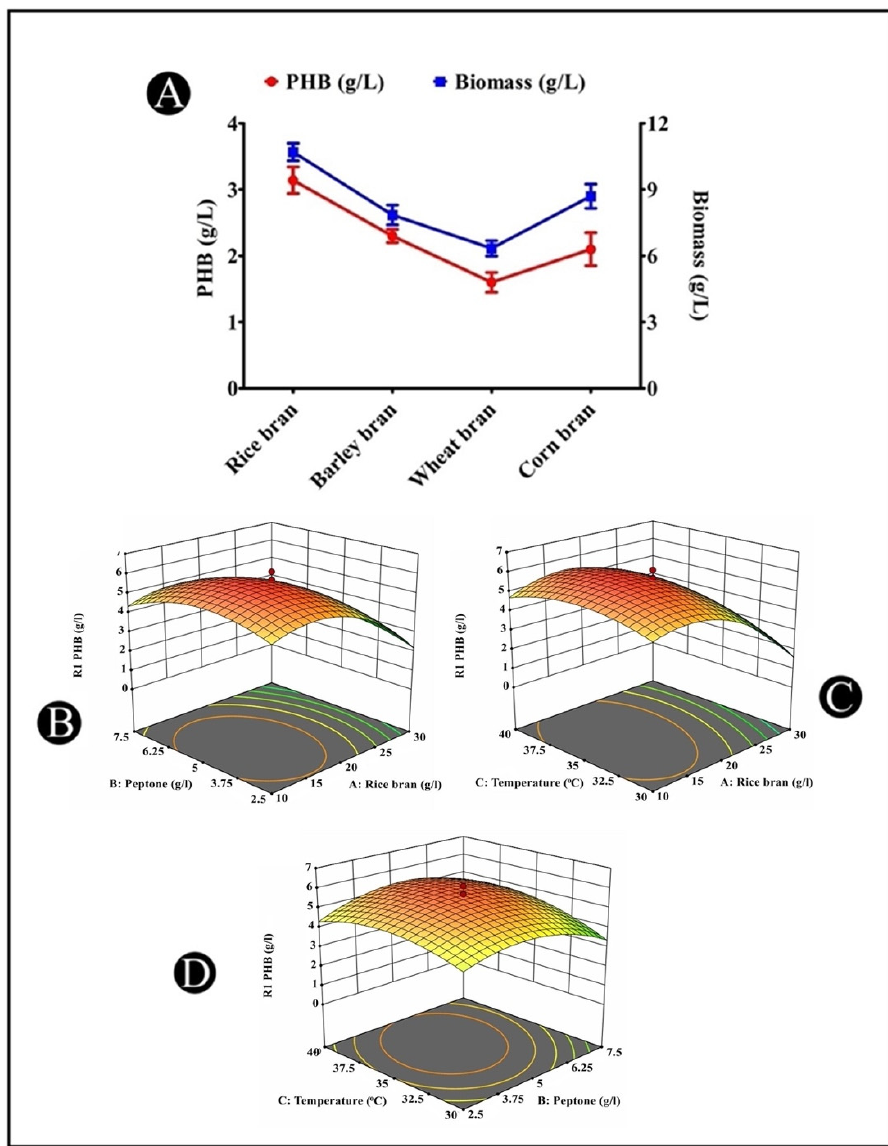
Figure 6. ( A ) Effects of different cheap agricultural wastes on the PHB production by A. indicus strain B2; ( B – D ) 3D surface plots representing PHB production from culture broth of A. indicus strain B2 as affected by cultural conditions: ( B ) rice bran and peptone; ( C ) rice bran and temperature; ( D ) peptone and temperature. The red dots indicate the optimal values of the variables taken in the study at which the highest accumulation of PHB was observed at that particular point.